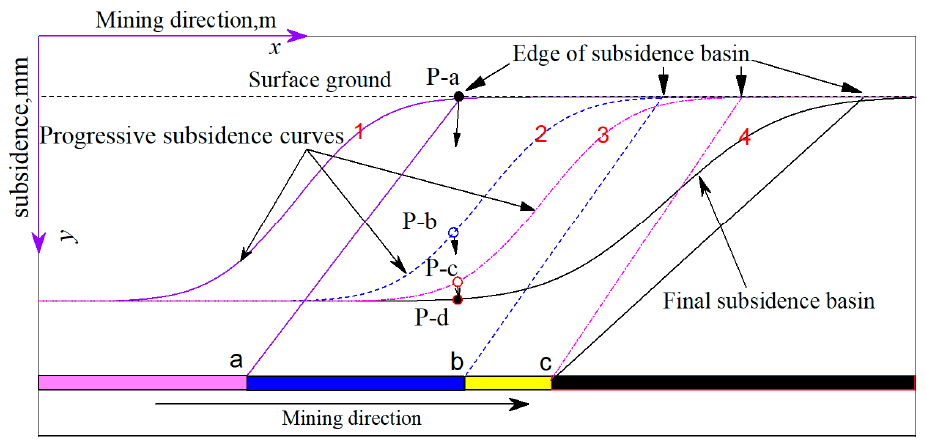
Figure 1. Subsidence process for surface point P during longwall coal mining: number 1, 2, and 3 represent progressive surface subsidence curves for different wall location; and number 4 refers to final surface subsidence curve.